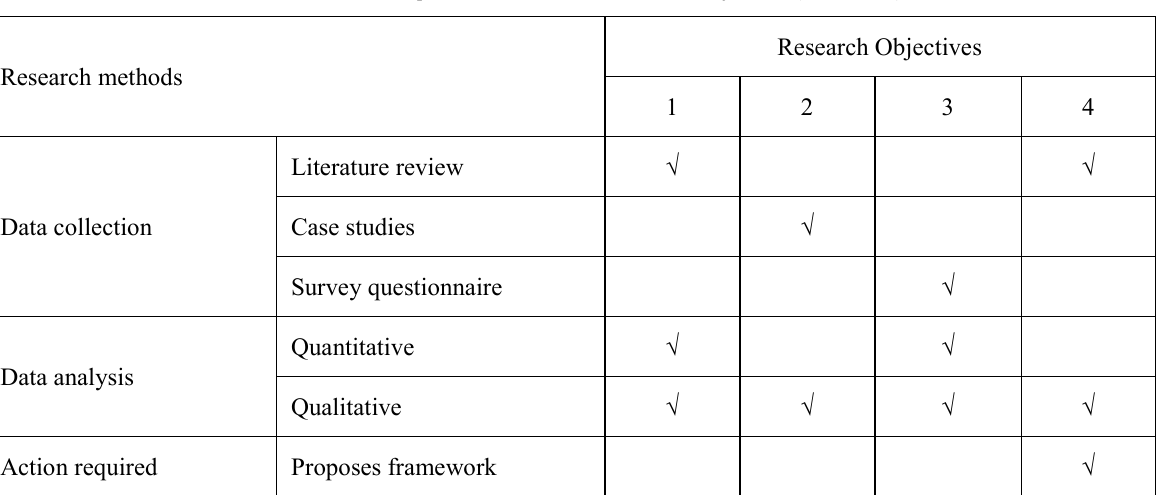
Table 6.The relationship between methods of research and objectives. (The